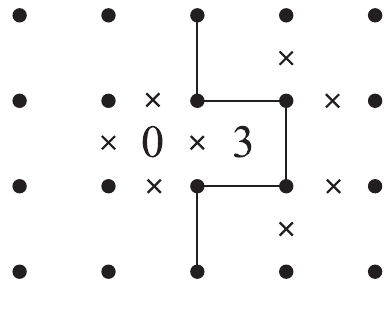
Figure 7. An example of information used by a heuristic Slitherlink